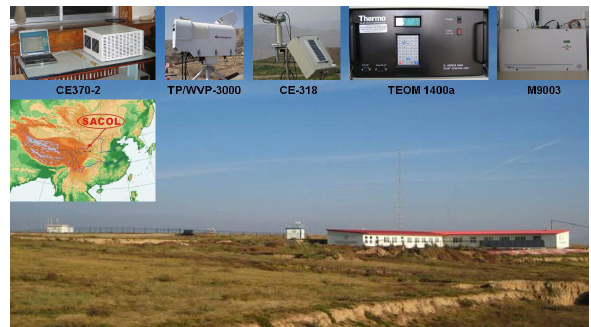
Fig. 1. Location of the Semi-Arid Climate and Environment Observatory of Lanzhou University (SACOL) and relevant instruments